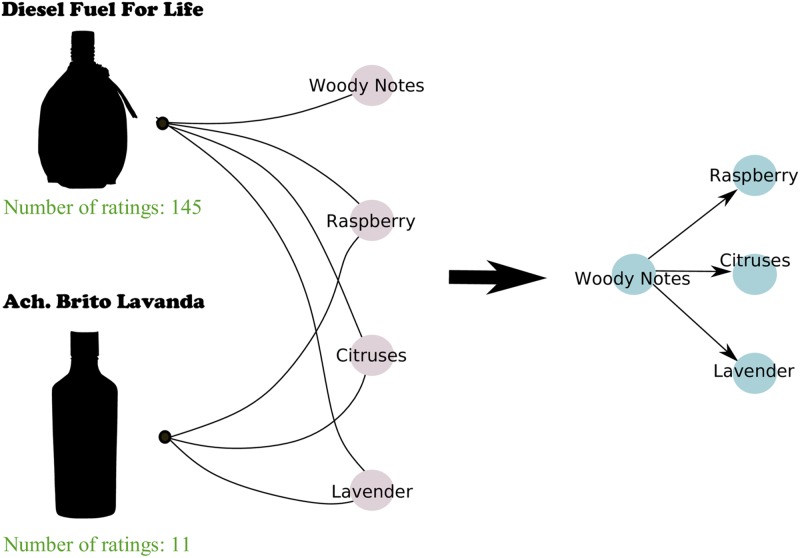
An example of an enhancement event in perfumes.Woody Notes are enhancing a composition of raspberry, citruses and lavender. The last three notes feature in both “Fuel for Life” and “Lavanda” however, “Fuel for Life” has an additional woody notes note and a higher number of reviews. Thus woody notes must be enhancing the composition of raspberry, citruses and lavender.